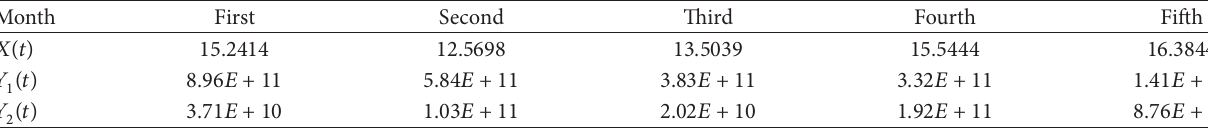
Table 9: The input and outputs center of gravity for DMU 8 .